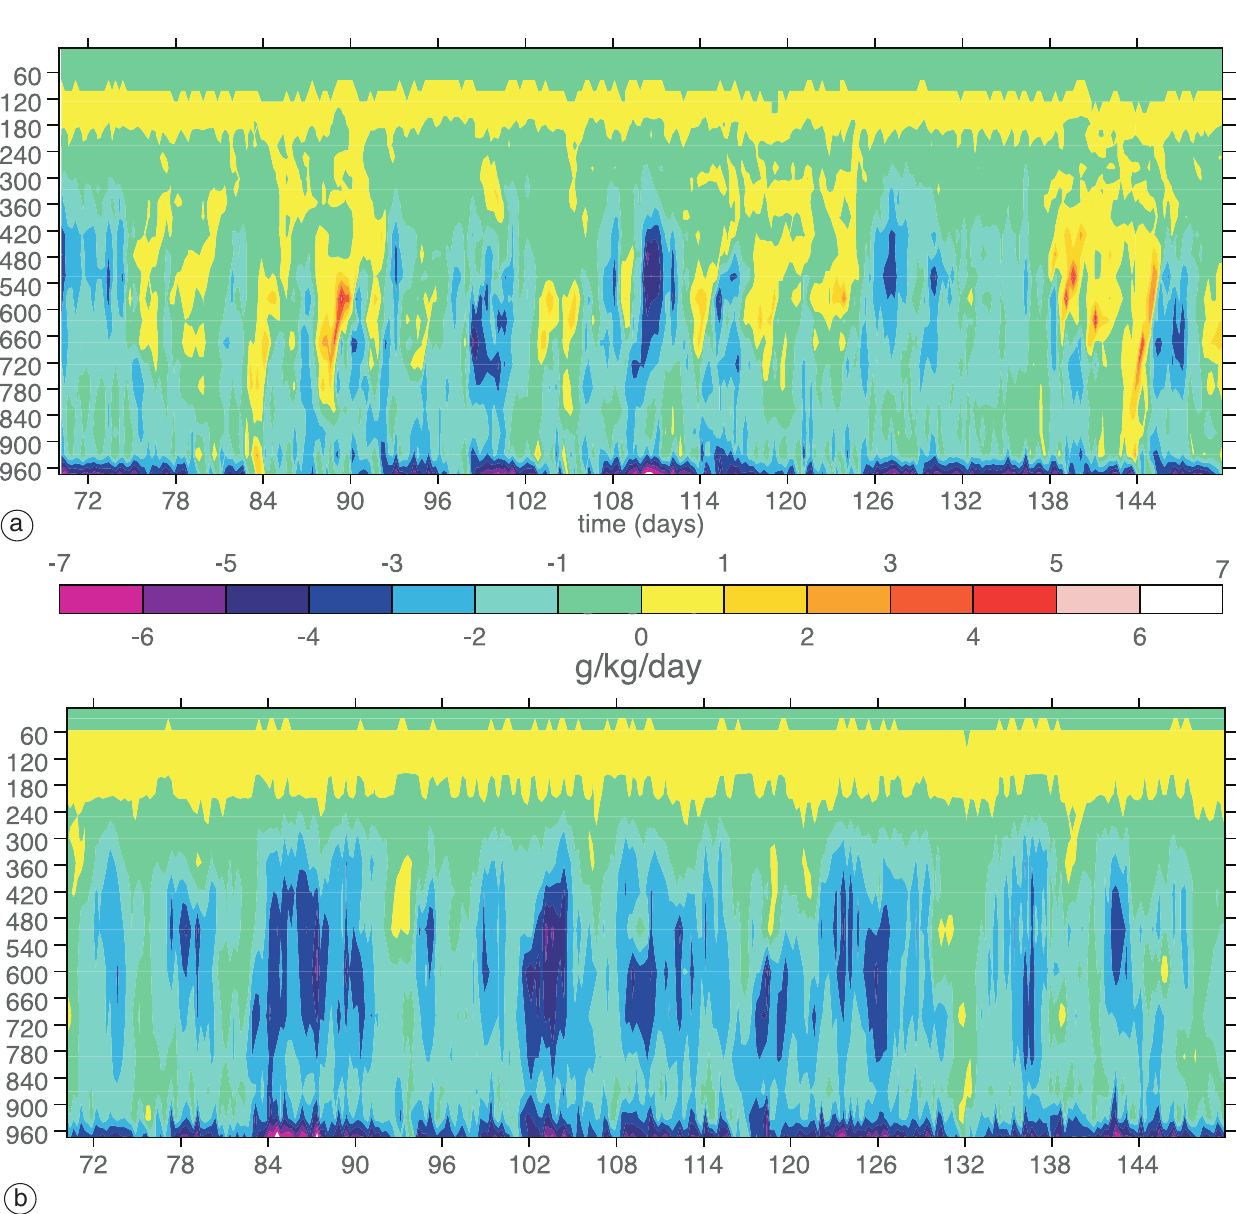
Fig. 7a,b. Time-height cross-sections of the increment to specific humidity due to the convective parametrization (g/kg/day) for a 90-day period from the aqua-planet integrations, averaged over a 3 × 3 grid-point box centred on the equator. a) L30 aqua-planet; b) L19 aqua-planet. From Inness et al.